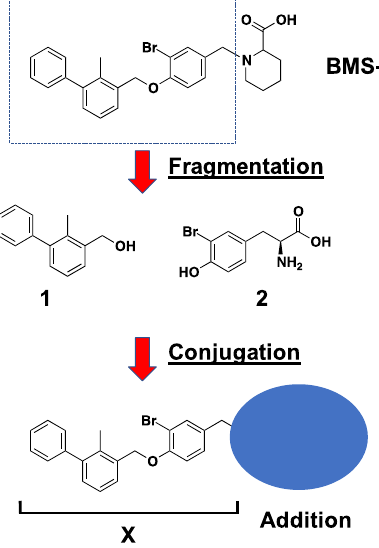
Figure 1. Strategies to improve inhibitory effect of BMS-8 . 3-hydroxymethyl-2-methylbiphenyl ( 1 ) and 3-bromotyrosine ( 2 ) were selected as fragmented structures. A biphenyl-conjugated